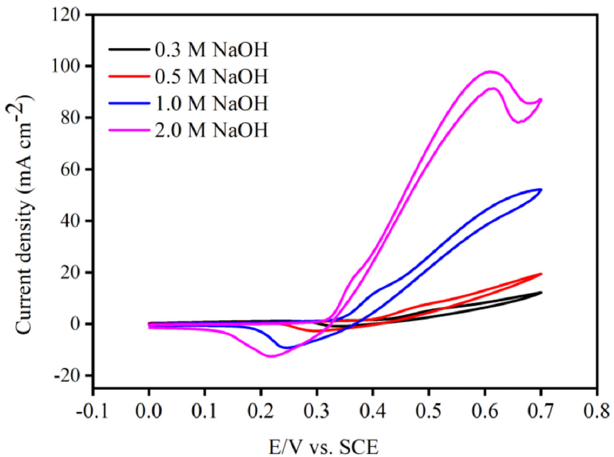
Figure 8. CV curves on NiCuOOH ‐ NF electrode at a scanning rate of 20 mV s − 1 in 0.4 M NH 4+ with different NaOH levels.